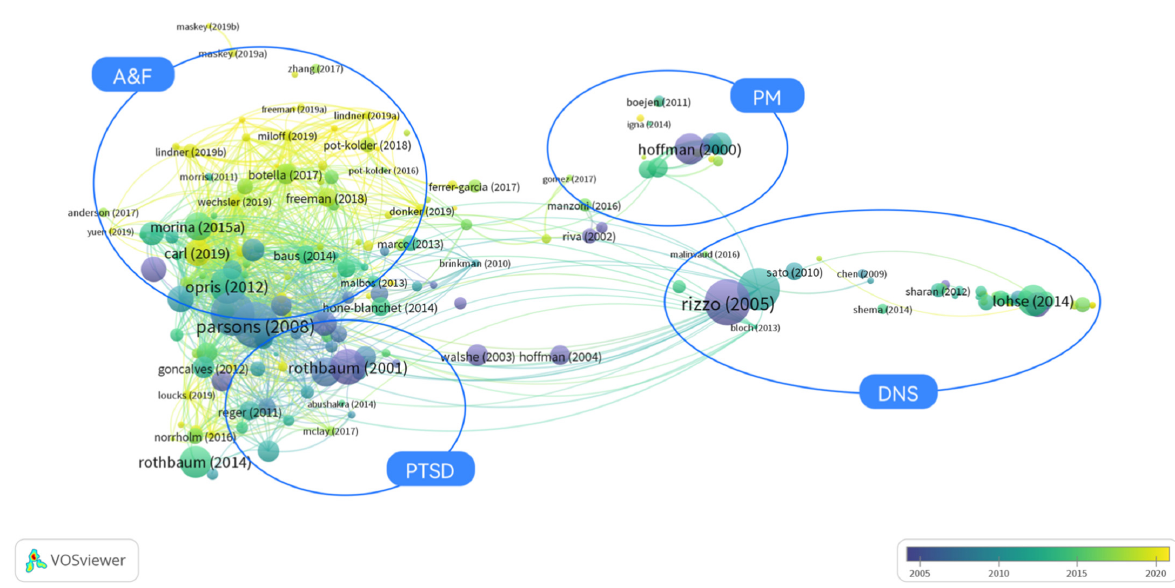
Figure 4. Overlay visualizations of bibliographic coupling analysis of the theme of VR and therapy within two decades (2000 to year 2020) in the WoSc via VOSviewer (devised and generated by the authors).